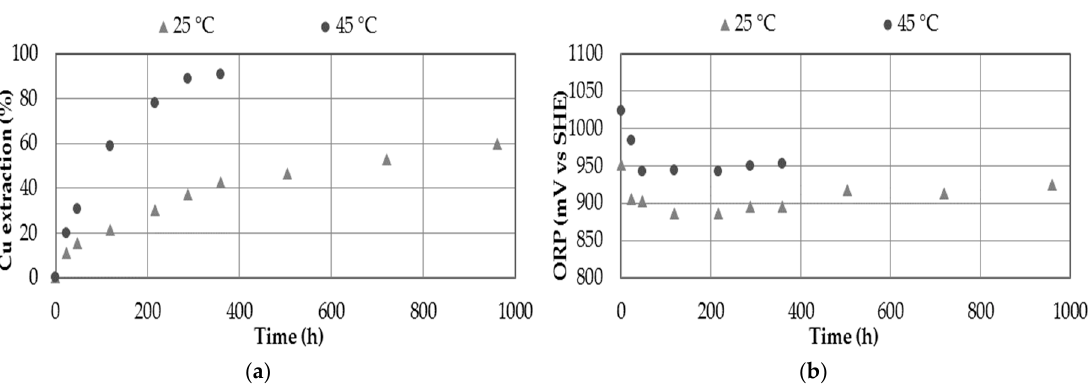
Figure 9. a) Copper extraction (%) versus time (h) at different temperature: 25 and 45 °C. b) Redox 281 Figure 9. ( a ) Copper extraction (%) vs. time (h) at di ff erent temperature: 25 and 45 ◦ C. ( b ) Redox potential (mV) versus time (h) at different temperature: 25 and 45 °C. Experimental conditions: 282 potential (mV) vs. time (h) at di ff erent temperature: 25 and 45 ◦ C. Experimental conditions: [NaNO 3 ] [NaNO 3 ] = [H 2 SO 4 ] = 0.7 M, seawater as dissolvent and sample A. 283 Figure 9. ( a ) Copper extraction (%) vs. time (h) at different temperature: 25 and 45 °C. ( b ) Redox = [H = 0.7 M, seawater as dissolvent and sample 2 SO 4 ] potential (mV) vs. time (h) at different temperature: 25 and 45 °C. Experimental conditions: [NaNO 3 ] = [H 2 SO 4 ] = 0.7 M, seawater as dissolvent and sample A.